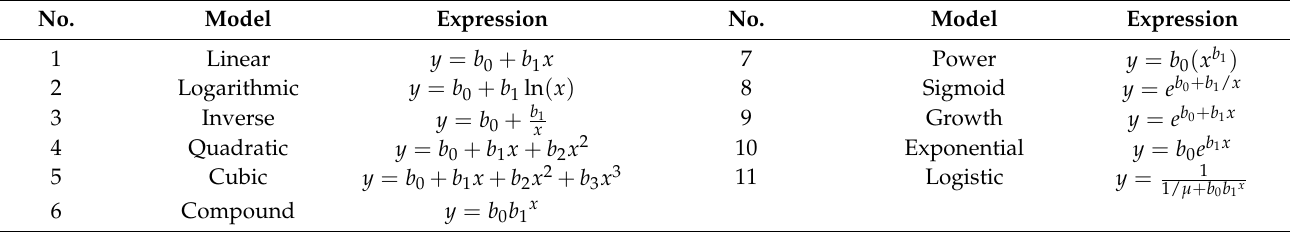
Table 2. Curve regression